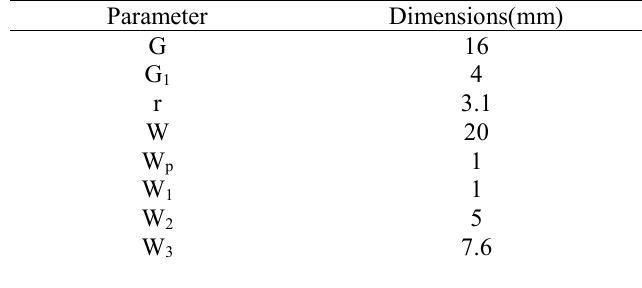
Table 1: Antenna